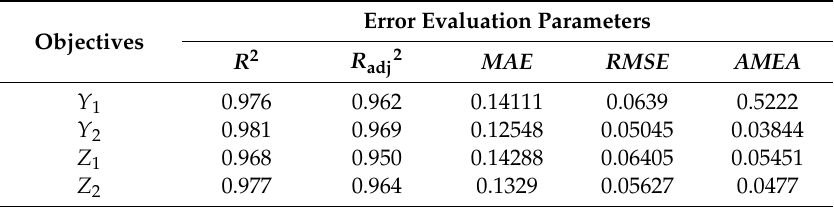
Table 5. The value of error evaluation index of each response approximate model.